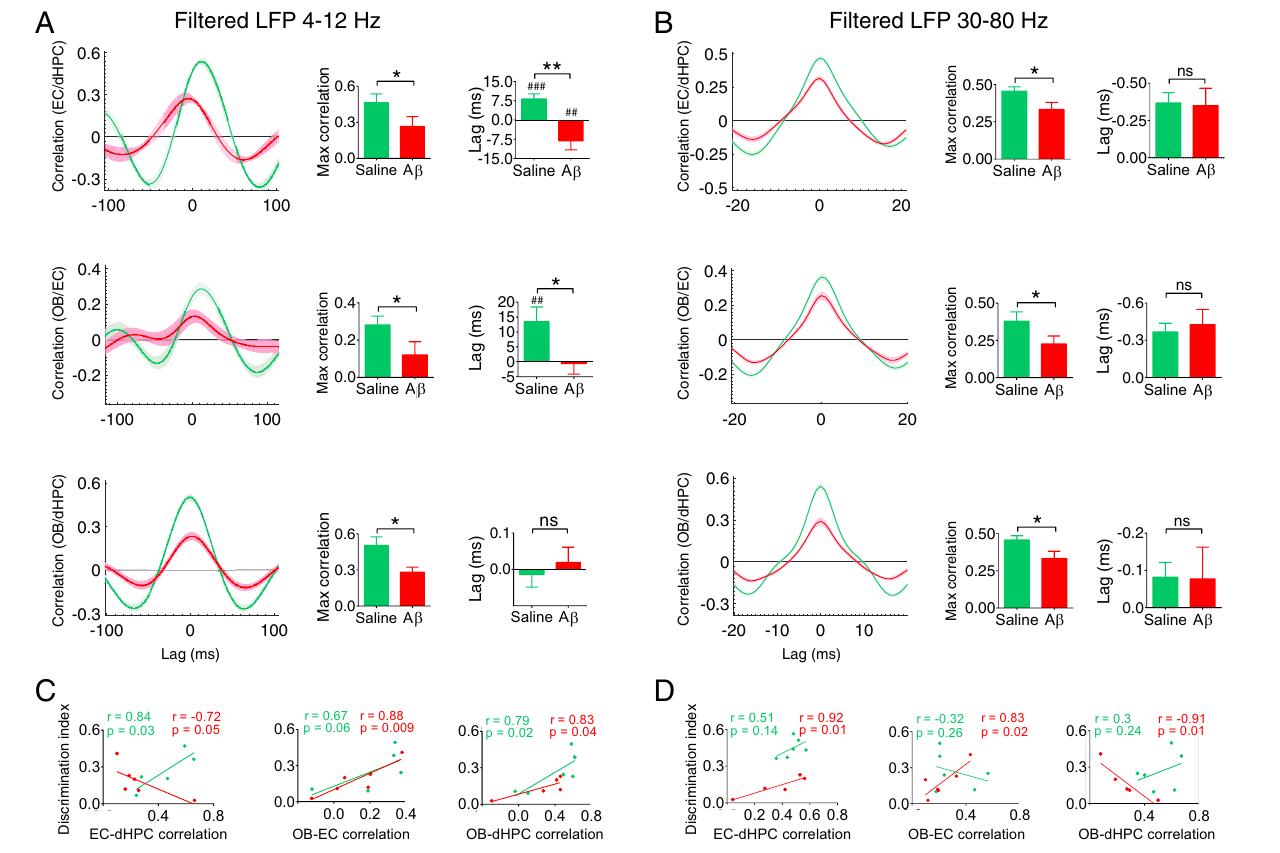
Figure 6. Aβ disrupts synchrony in the OB-EC-dHPC circuit during recognition memory performance. ( A and B ) Mean correlation in time lag at theta and gamma bands, respectively. The network correlation in Aβ animals decreased at both theta and gamma ranges compared to the saline group. A reduction was found at the theta band for information influx lag from OB to EC and EC to dHPC in Aβ animals. Moreover, Aβ animals showed an inverted direction of information influx from OB to EC and EC to dHPC at theta band. ( C and D ) Correlation between task performance and synchrony at theta and gamma bands, respectively. A correlation was found between NOR performance and synchrony in the OB-EC-dHPC circuit at theta and gamma bands. At theta band, NOR performance was positively correlated with OB-dHPC and OB-EC synchrony for both groups. Also, in the EC-dHPC circuit, this correlation was negative and positive for Aβ animals and the saline group, respectively. At the gamma band, the correlation was negative between NOR performance and circuits for Aβ animals. Lines display the mean of correlation coefficient across the lag, and the shaded area represents SEM. Bar graphs are generated by an average of maximum coefficient and lag values for cross-correlation. Comparisons were conducted by t-test and Pearson correlation coefficients. n = 6 per group. For Pearson correlation, data were assessed regarding outliers. * p < 0.05, ** p < 0.01; ns, not significant. ## p < 0.01, ### p < 0.001 according to one-sample t-test comparison with the constant value of zero. Aβ amyloid-beta, OB olfactory bulb, EC entorhinal cortex, dHPC dorsal hippocampus, NOR novel object